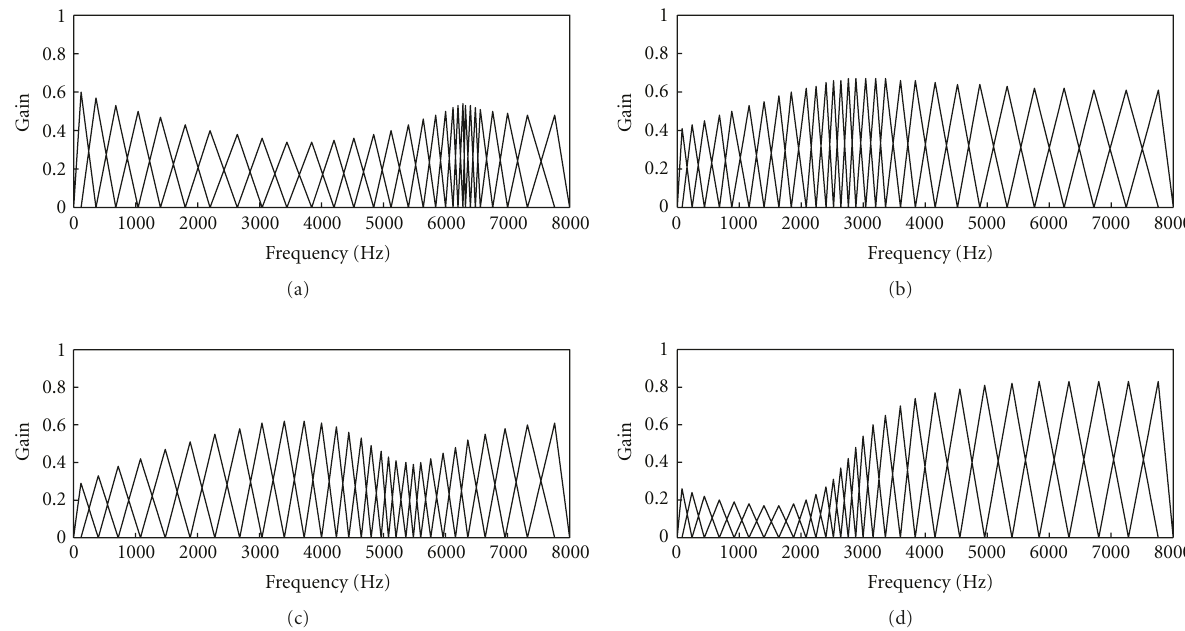
Figure 7: Evolved filterbanks obtained in the optimization of filter center positions and amplitudes simultaneously and using signals with noise at 0 dB SNR: (a) EFB-C1, (b) EFB-C2, (c) EFB-C3, and (d) EFB-C4.